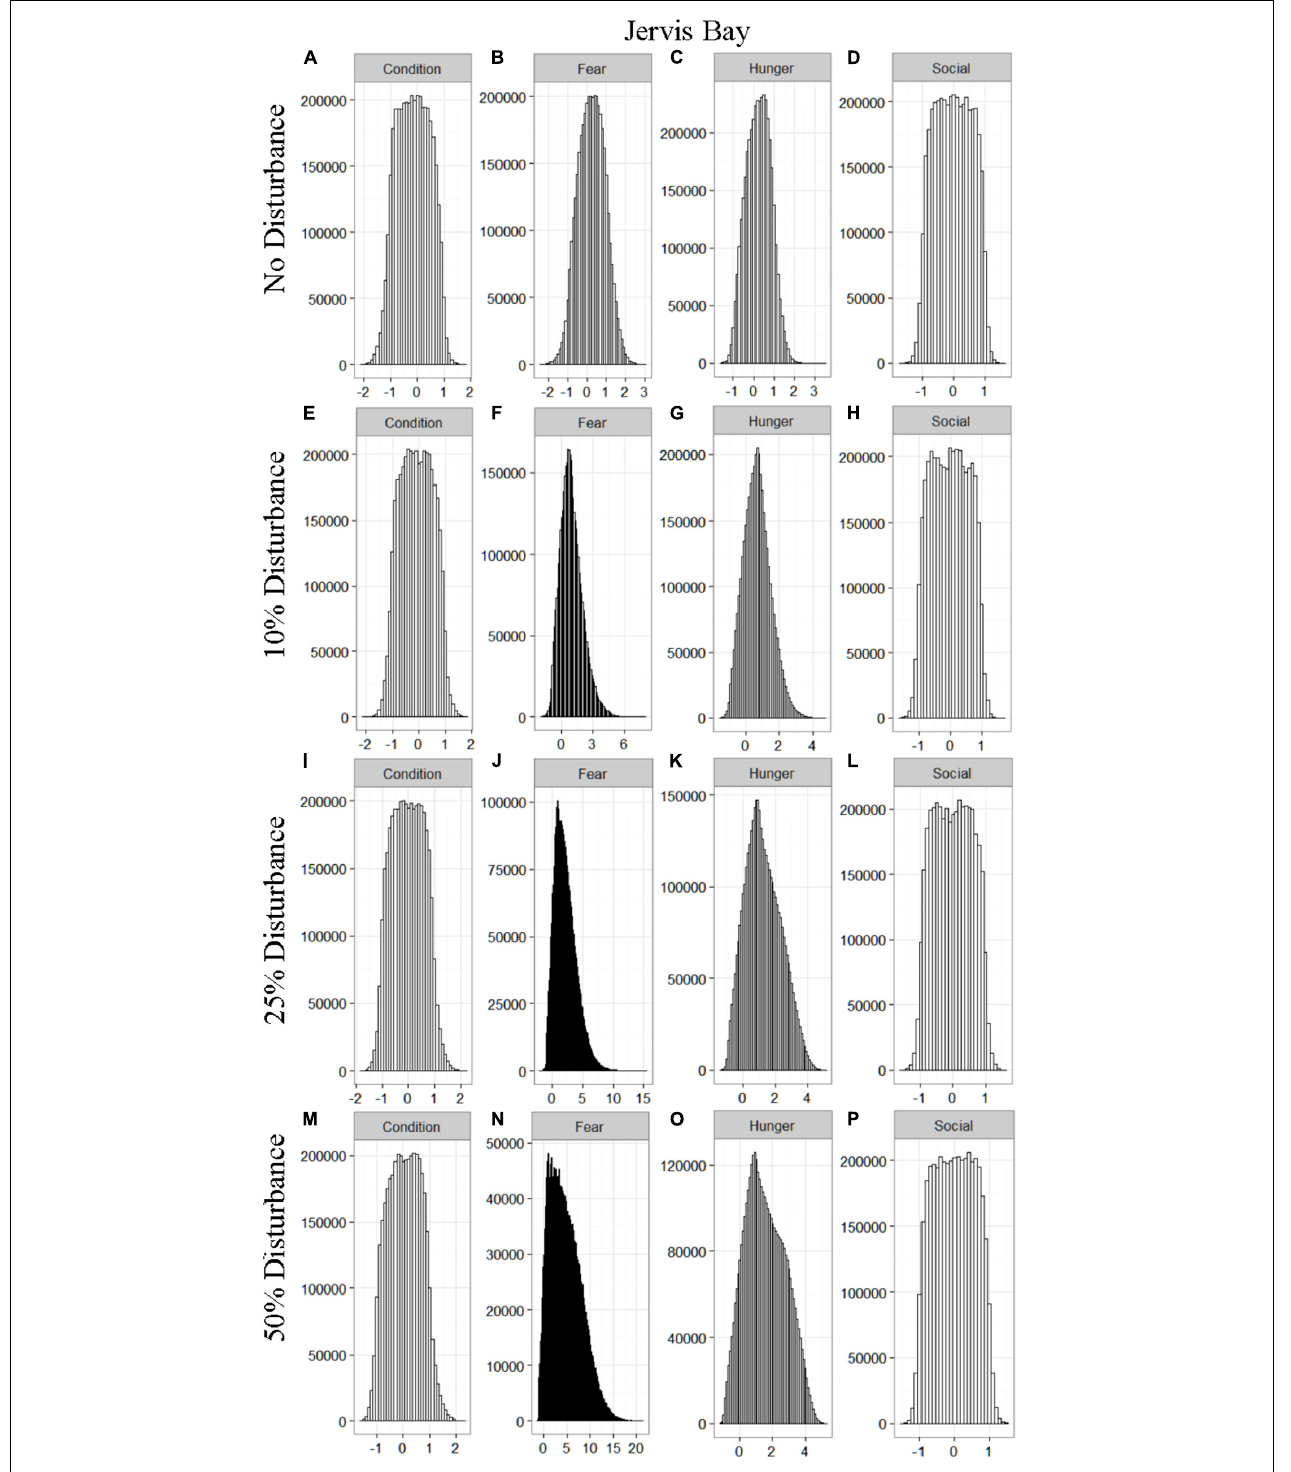
FIGURE 4 | The four motivational states of condition (A,E,I,M) , fear (B,F,J,N) , hunger (C,G,K,O) , and social need (D,H,L,P) for the simulated Jervis Bay population under each of the four disturbance scenarios: no disturbance (A–D) and a 10% (E–H) , 25% (I–L) , or 50% (M–P) chance of an individual being disturbed when in the area used by whale-watching vessels. The y -axis is the cumulative count over all simulations, while the x -axis is a unit-less measure of individual motivation. Motivation is centered at zero (i.e., indifference) and can take on negative values to indicate a lack of incentive (i.e., satisfaction) and positive values to indicate strong incentive (i.e., discontent) (New et al.,